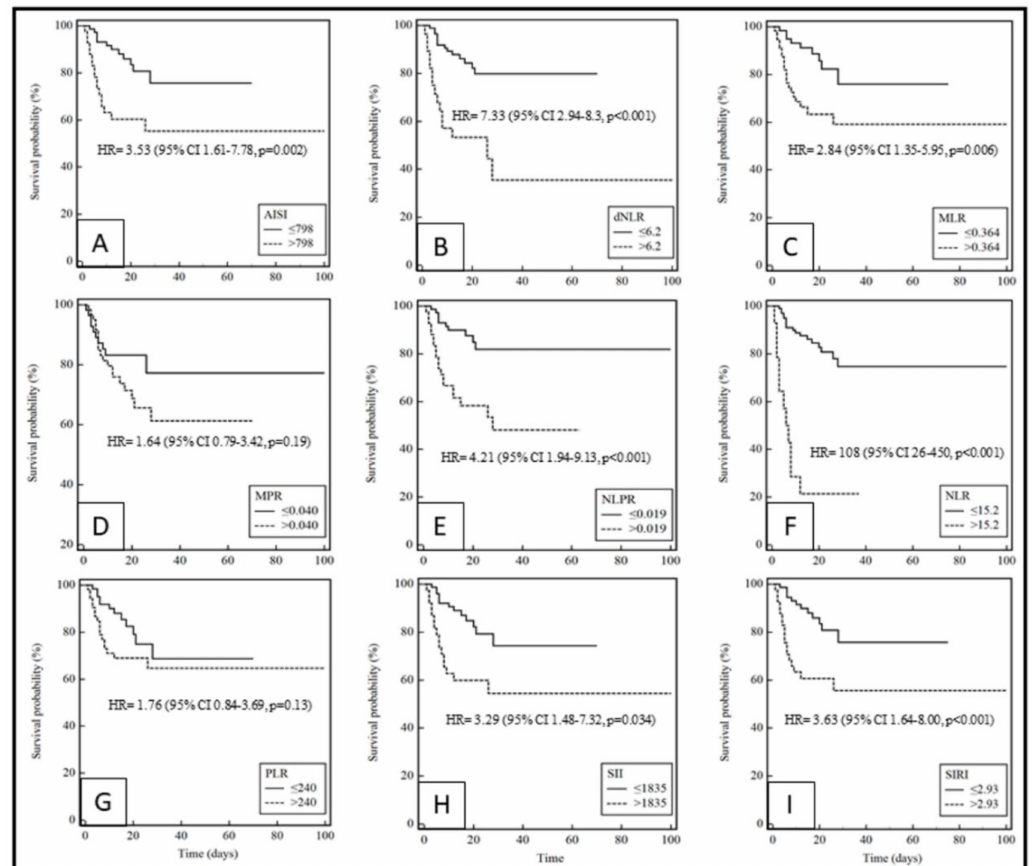
Figure 1. Kaplan–Meier survival curves during hospitalization of COVID-19 patients with di ff erent cut-o ff values of the systemic inflammation indexes investigated. ( A ): AISI; ( B ): dNLR; ( C ): MLR; ( D ): MPR; ( E ): NLPR; ( F ): NLR; ( G ): PLR; ( H ): SII; ( I ):